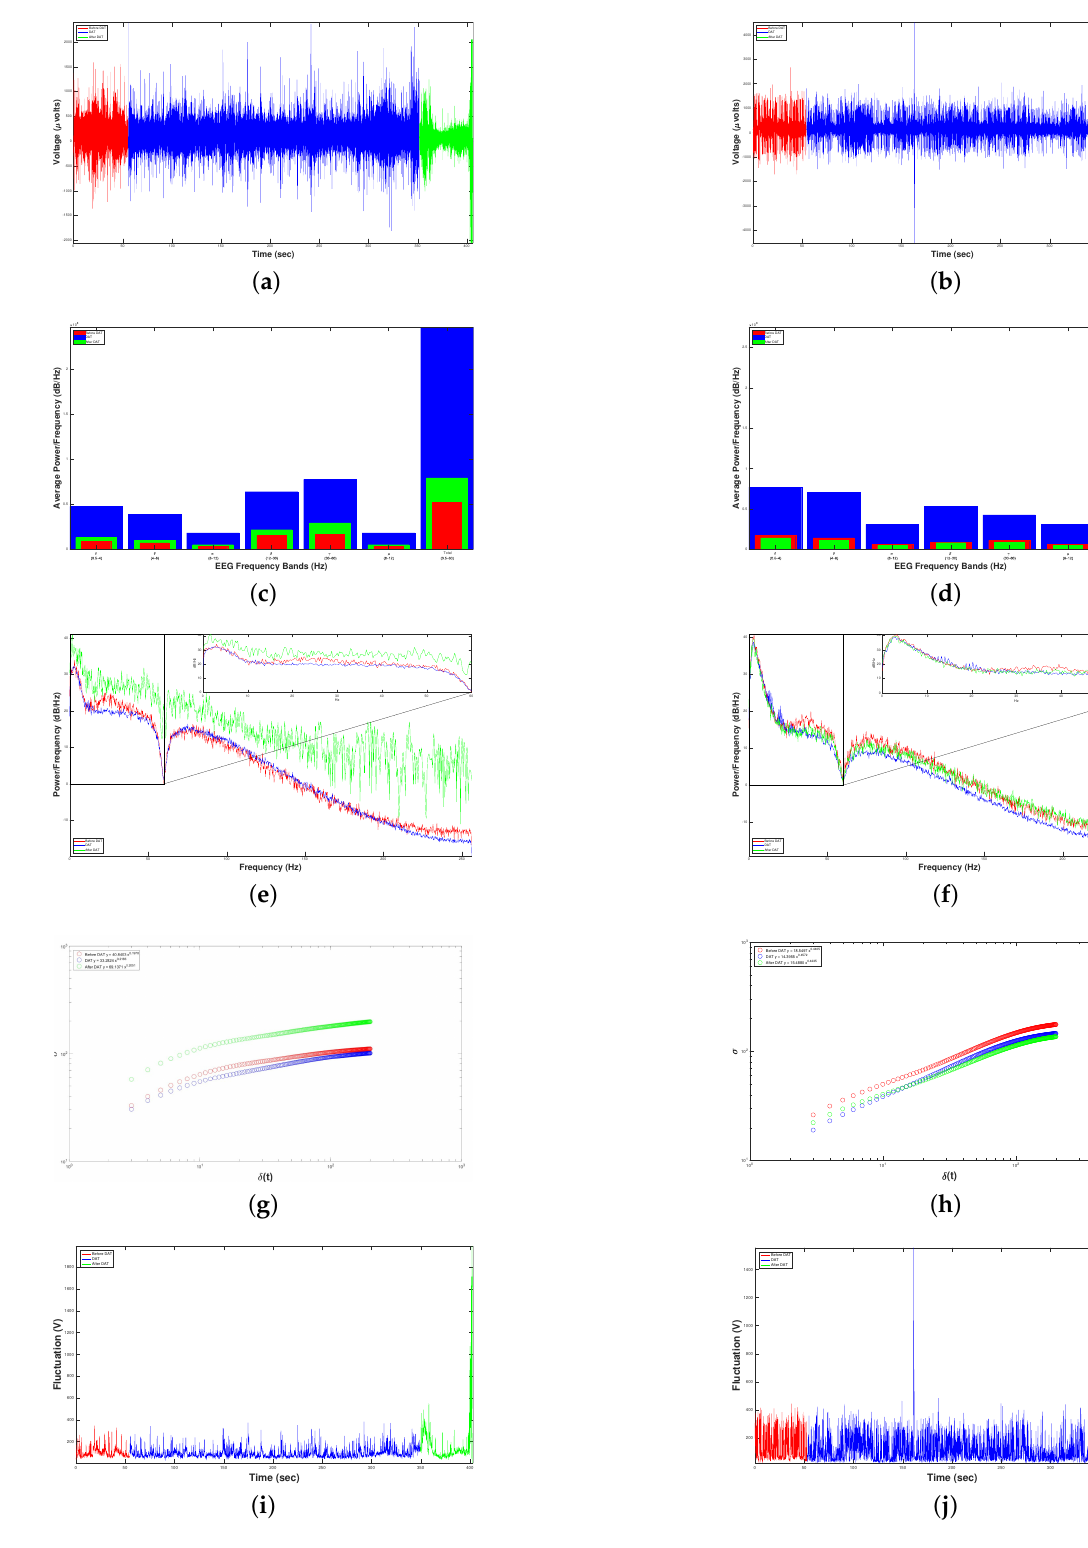
Figure 9. Results of DAT efficiency for RAW EEG Brain activity (first row, ( a ),( b )) of two child patients (each column is a patient). Periodogram (second row, ( c )–( d )) and Average Spectogram (third row, ( e )–( f )) using FFT Power Spectrum Density. Fluctuations EEG Brain activity (fourth row, ( g )–( h )) and Crossover (fifth row, ( i )–( j )) using Self-Affine Analysis . The functions in red mean the sample taken before DAT, while blue and green ones mean during DAT and after DAT,